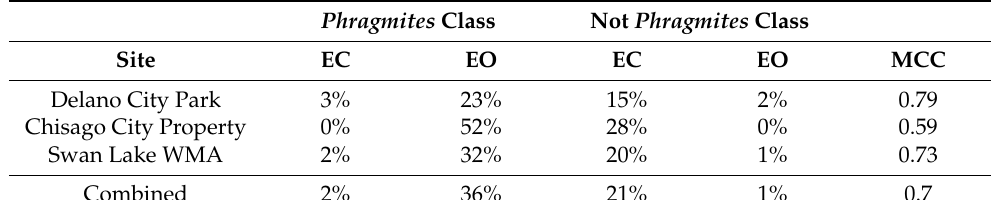
Table 15. Errors of commission (EC), errors of omission (EO), and Matthews correlation coefficient (MCC) values for the random forest classification without the post-ML OBIA rule set.